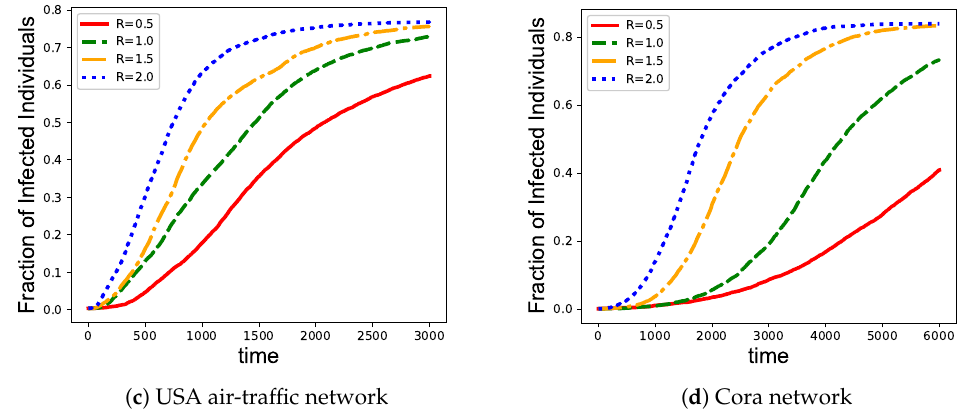
Figure 5. Performance comparison among different immunization strategies on four benchmark networks given different transmission rates. ( a ) Brazilian air-traffic network; ( b ) European air-traffic network; ( c ) USA air-traffic network; and ( d ) Cora network. The x axis represents the infection time of the nodes. The y axis represents the fraction of infected nodes in the